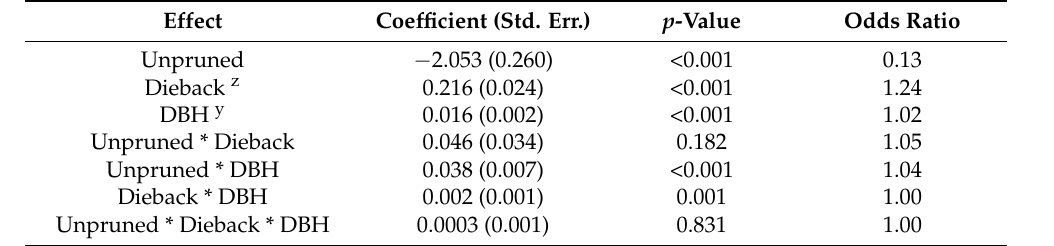
Table 4. Odds ratios of significant effects (and their interactions with one another) in the ordinal logistic regression model to predict likelihood of failure (see Table 3). Coefficients (on the log scale) are relative to baseline model of pruning status = pruned which has an odds ratio of 1. Exponentiated from coefficients, odds ratios indicate the magnitude of the change in the odds of having a higher likelihood of failure rating (i) for unpruned compared to pruned trees or (ii) for a one unit increase in percent crown dieback or DBH. Odds ratios greater than one indicate an increase in the odds of having a higher likelihood of failure rating; odds ratios less than one indicate a decrease in the odds of having a higher likelihood of failure